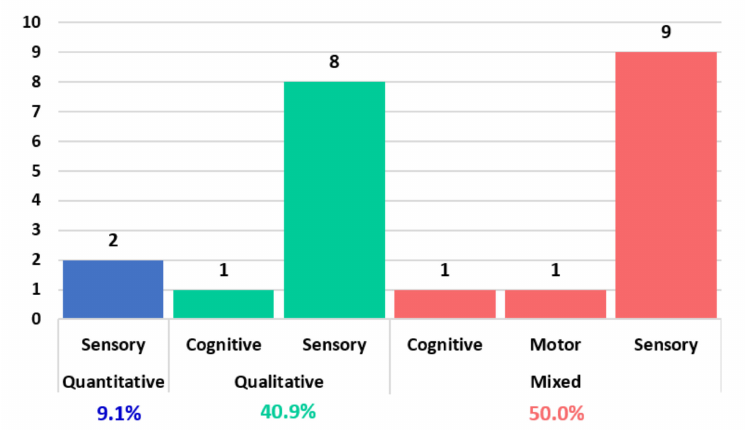
Figure 5. Type of applied research according to disability for accessible mobile applications.